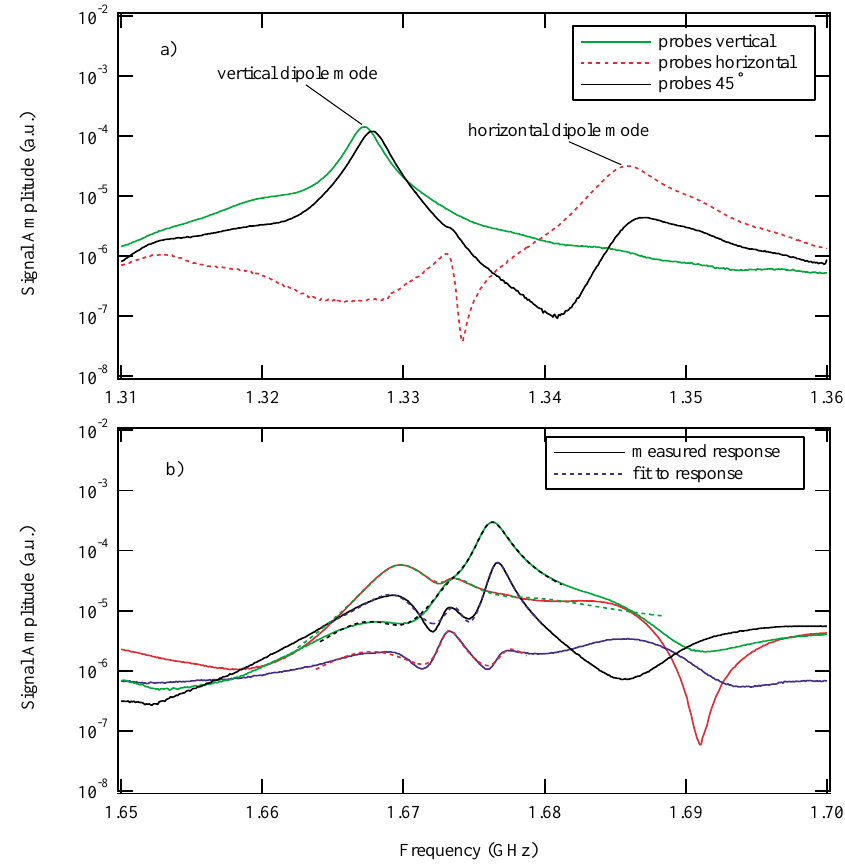
FIG. 6. (Color) Examples of measured transmission spectra on the bench at various probe angles. (a) For dipole modes which are well separated, determination of the Q is simple. (b) More crowded spectra require fitting to multiple peaks with different relative phases, resulting in a larger uncertainty. range of uncertainty estimated by combining these